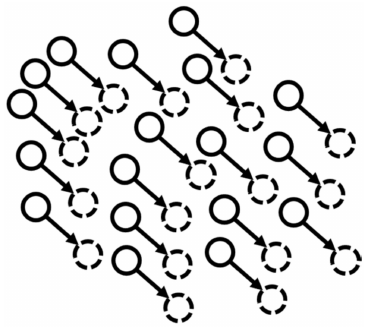
Figure 6. PIV tracer